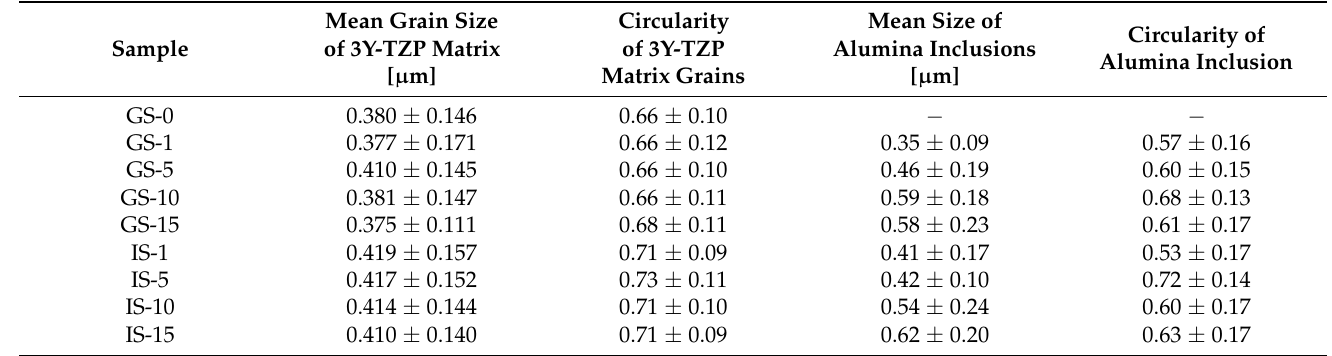
Table 4. The mean size of the grains of the 3Y-TZP matrix and the alumina inclusions as well as their circularity for unmodified 3Y-TZP (GS-0) and two series of 3Y-TZP/Al 2 O 3 composites with alumina added using two different methods (gelatin method—GS samples; and impregnation—IS samples).